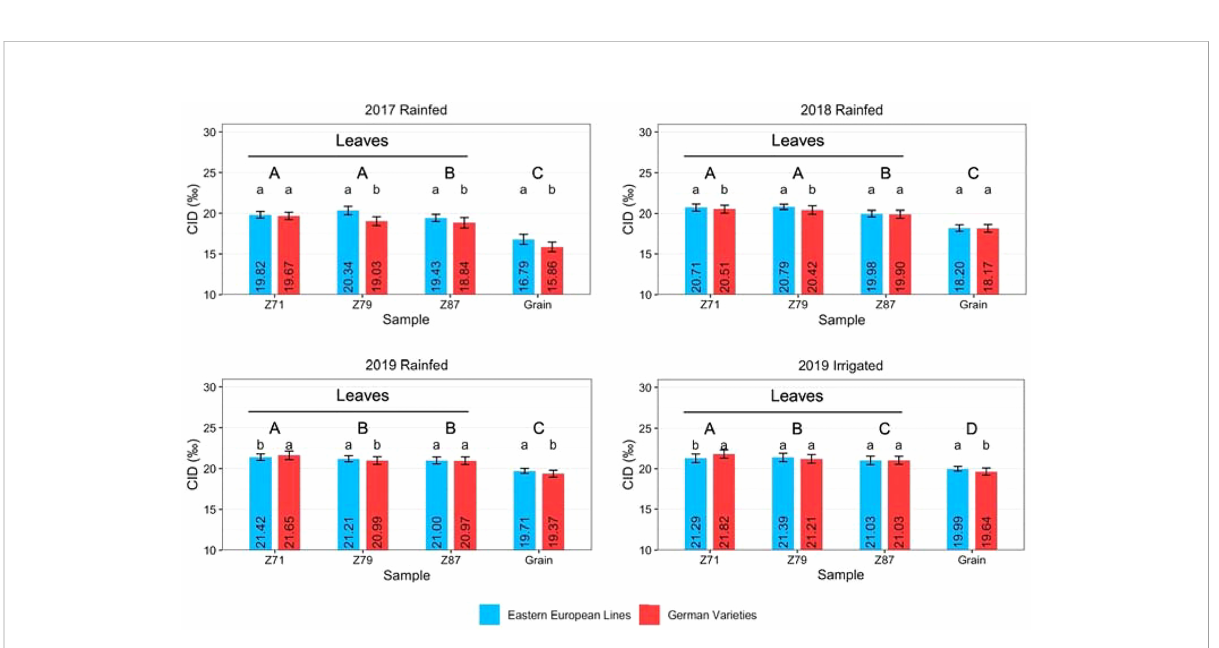
The vertical bars indicate the standard deviation of the mean. Different letters show signi fi cance between origins within the individual years and